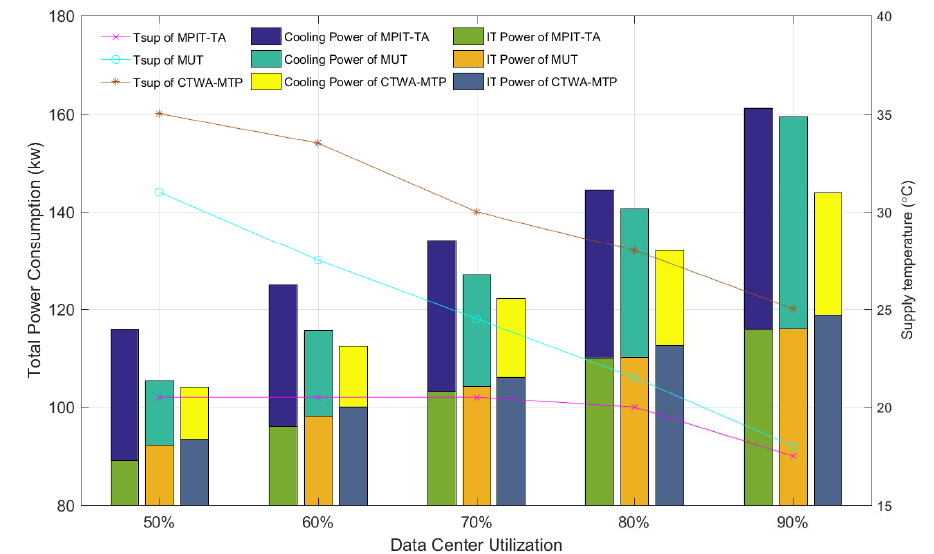
Figure 5. Power consumption under different